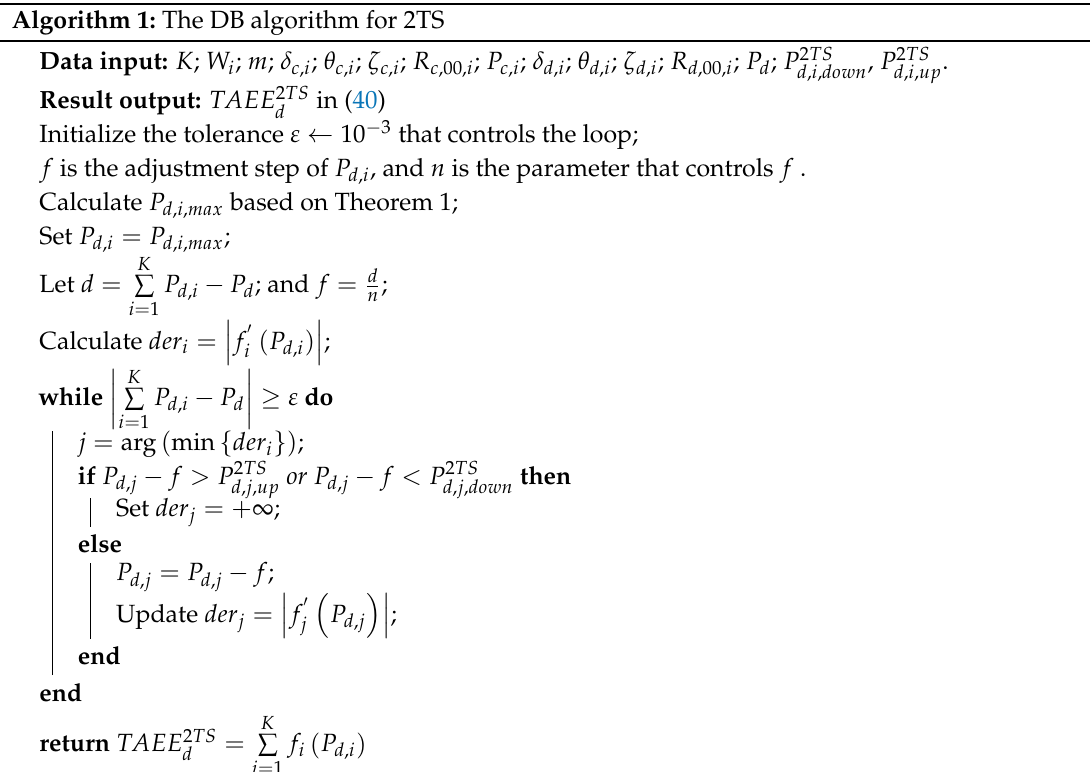
Algorithm 1: The DB algorithm for